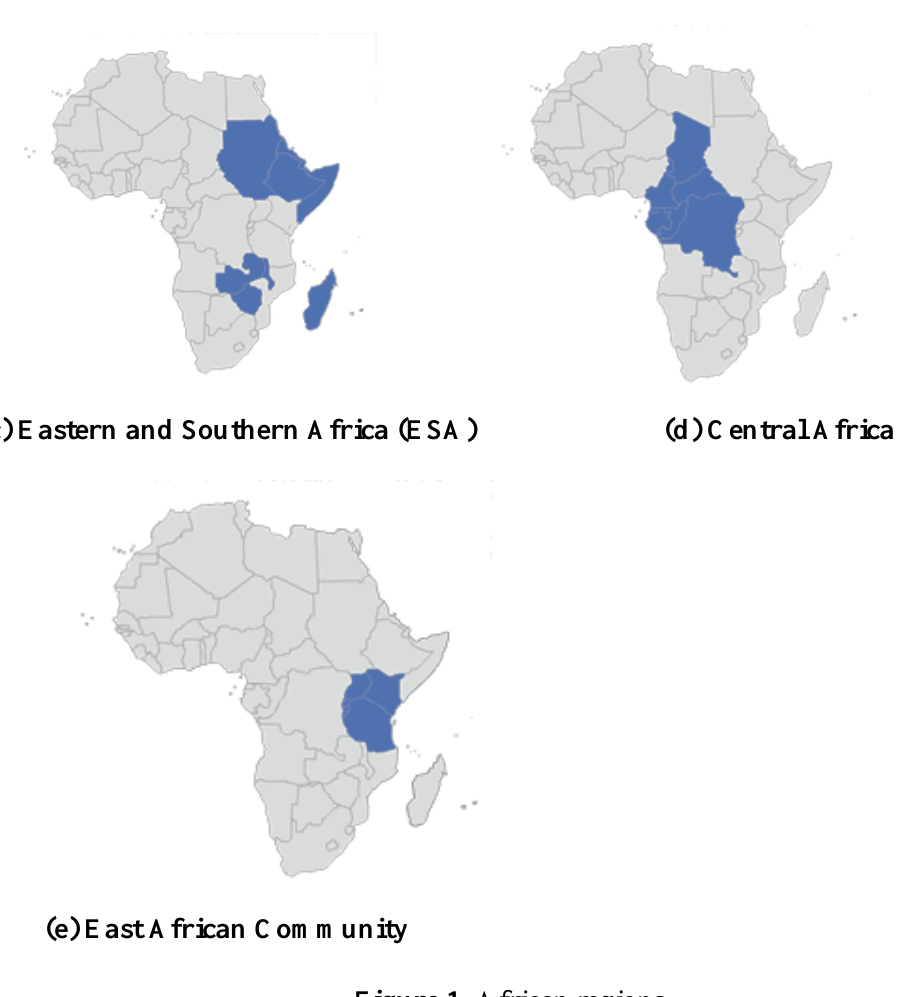
Figure 1. African